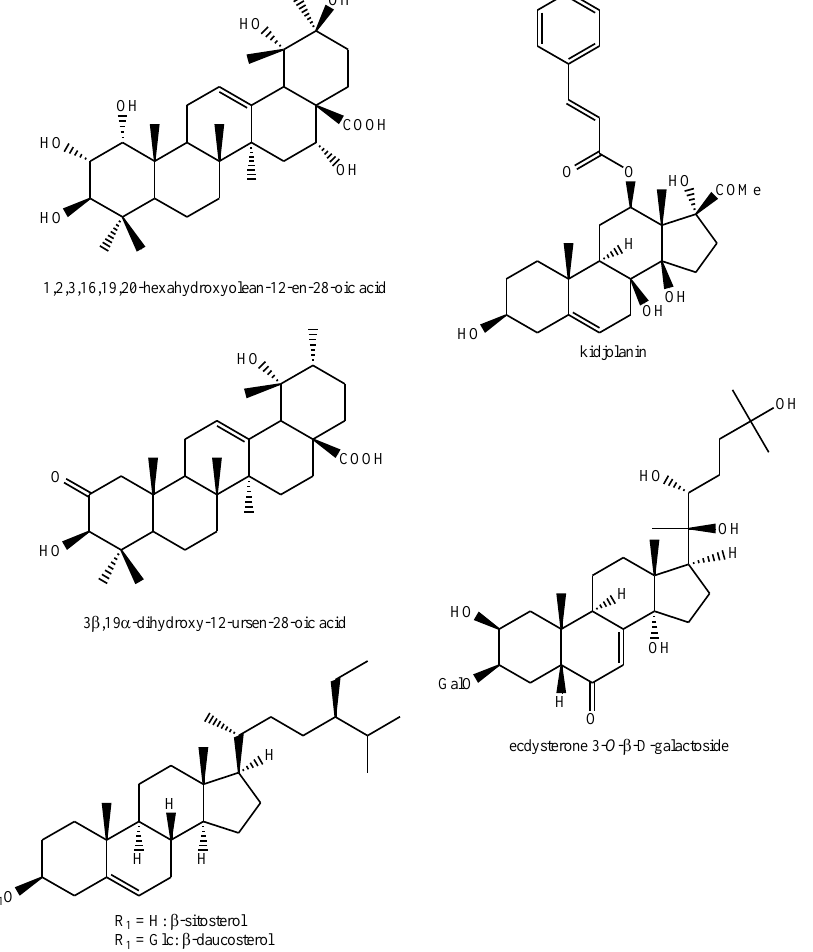
Figure 4. Terpenoids identified in Pedicularis species.